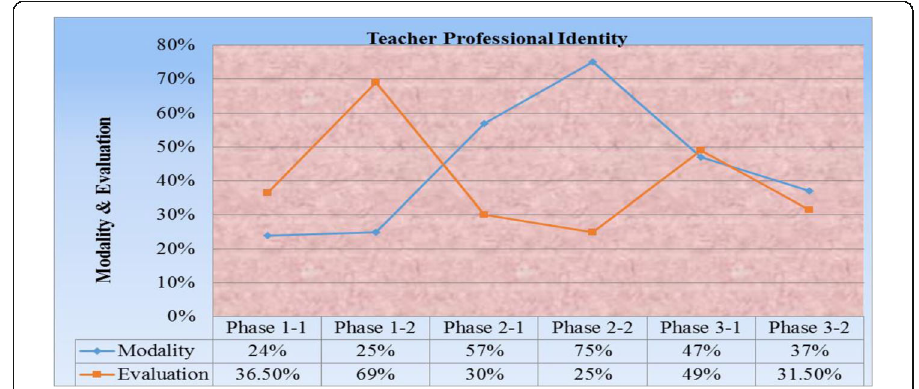
Fig. 3 Commitment to Modality and Evaluation across Three